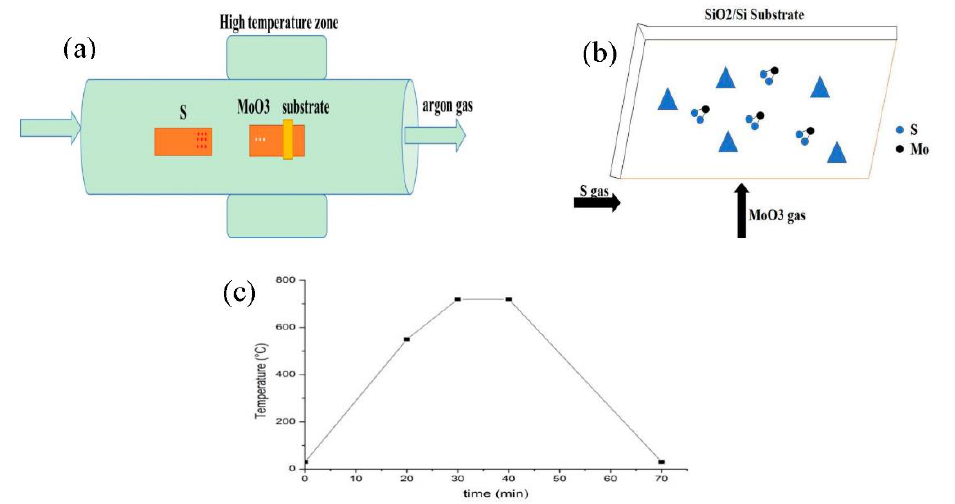
Figure 1. ( a ) Schematic illustration of the single temperature zone chemical vapor deposition (CVD) system; ( b ) schematic diagram of the MoS 2 growth; ( c ) temperature change curve diagram of the SiO 2 /Si substrate.